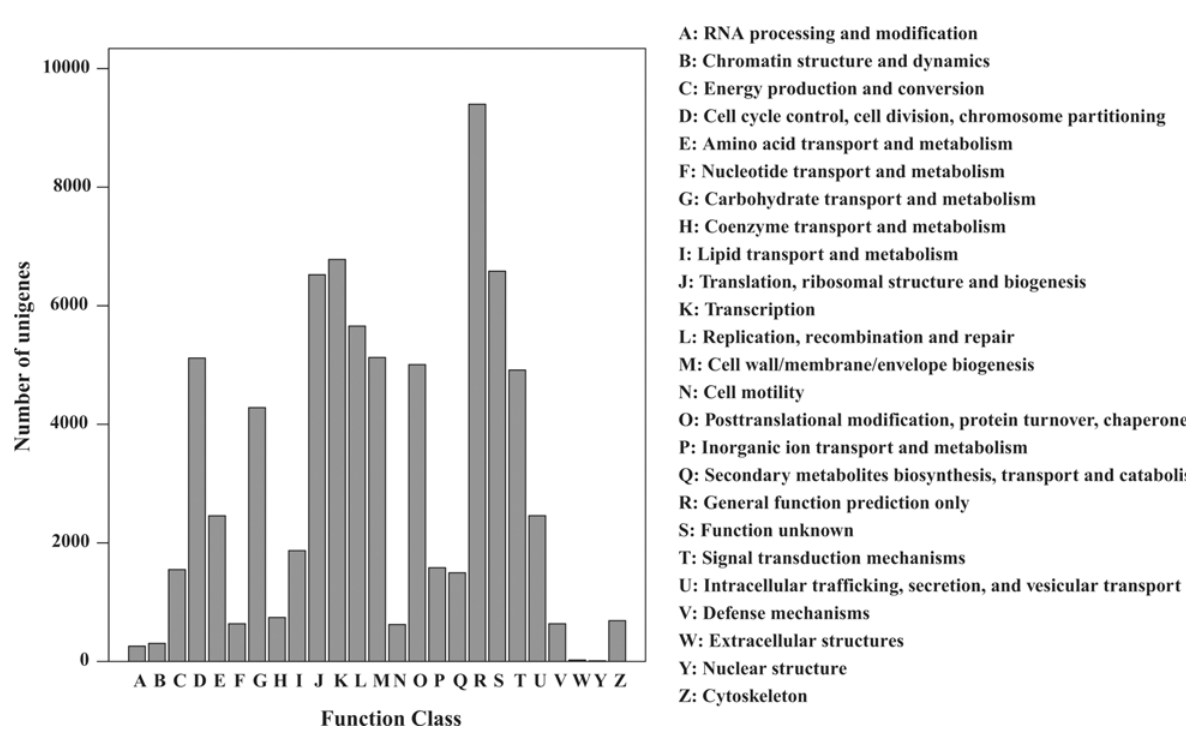
PLOS ONE | DOI:10.1371/journal.pone.0122641 April 13,